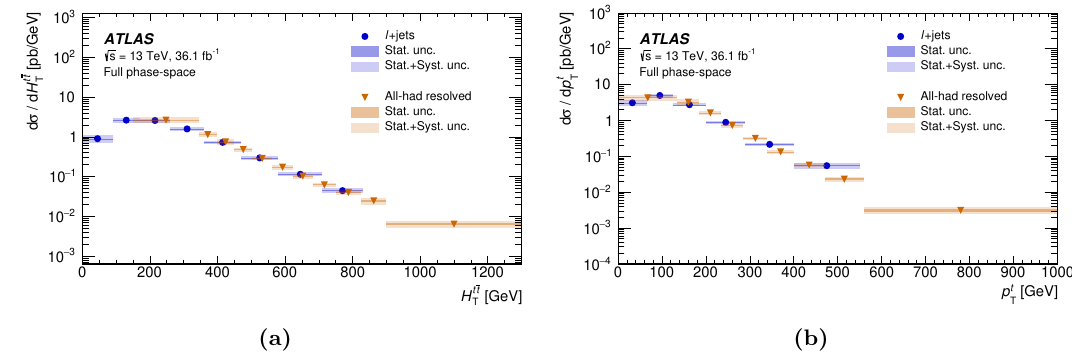
Figure 23 . Comparison between the measured absolute single-differential cross-sections in the ‘ +jets and all-hadronic channels as functions of (a) H t ¯ t tum p t T